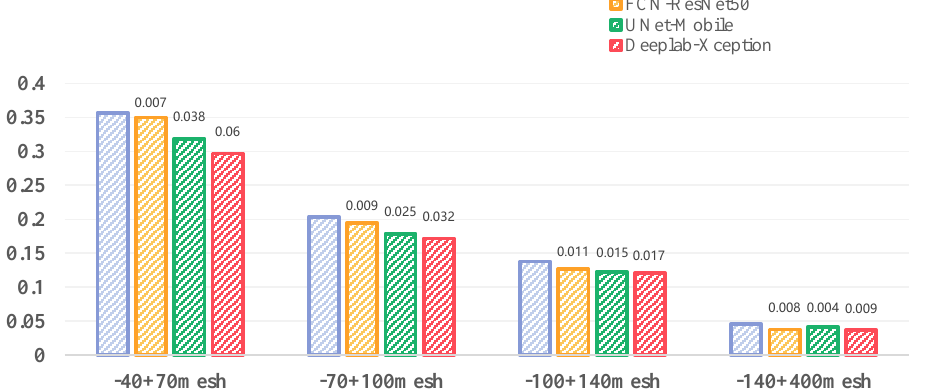
Figure 11. Comparative and analysis graph of particle size measurement.